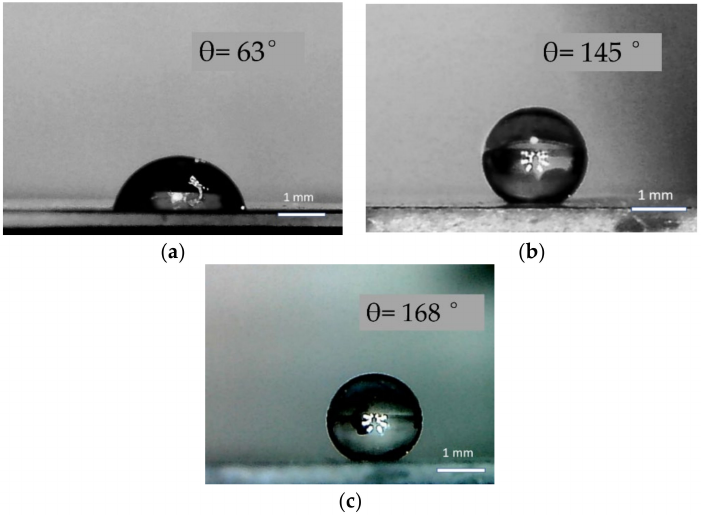
Figure 3. Shape of water droplets and contact angles on the surface of a pure Au film ( a ), ZnO samples of type I pure ( b ), and with Au ( c